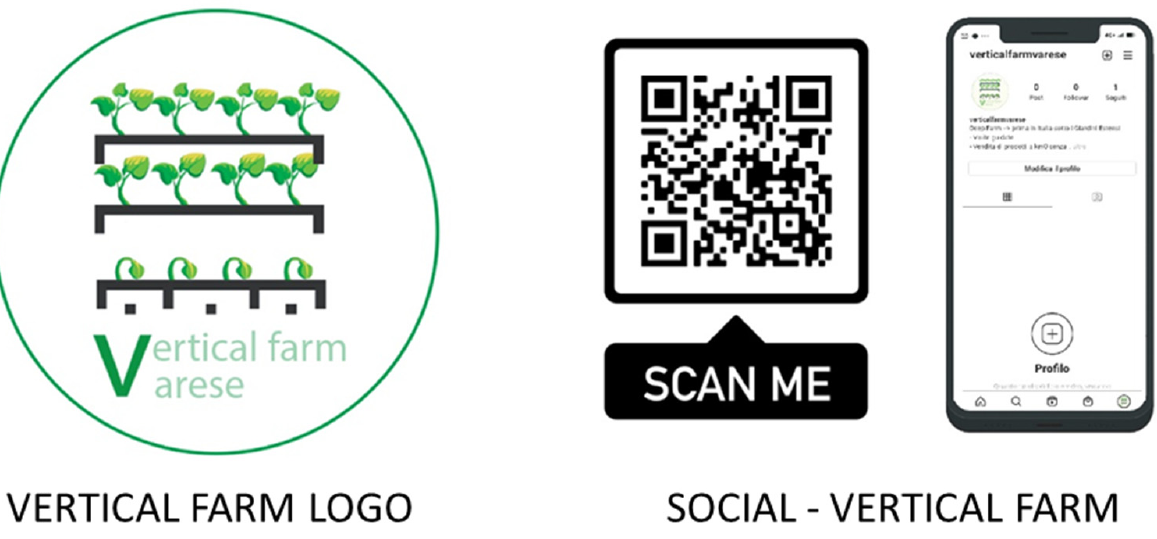
Figure 11. The logo and app created for the promotion of a Deep Farm by A. Pilo.